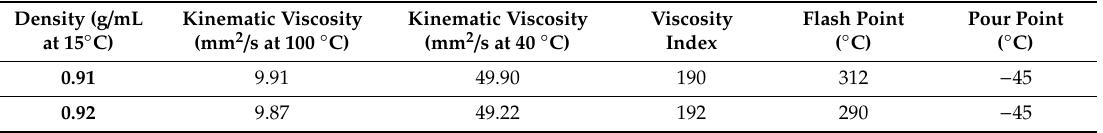
Table 1. Properties of the commercial biodegradable lubricant BIO TELEX 46 (top row) and its corresponding base biodegradable oil (bottom row).